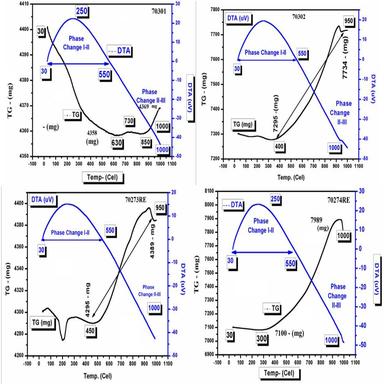
Results of TG-DTA of all four NEG alloys.